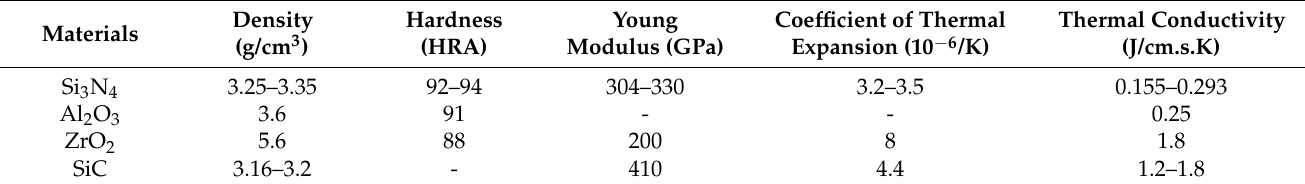
Figure 1. Real/possible applications of ceramics: ( a ) ceramic implant system in medical application [25], ( b ) ceramic turbine rotor [26], ( c ) ceramic crown [27], ( d ) unicondylar knee prostheses [28], ( e ) ceramic femoral head [29], ( f ) ceramic liner [30], ( g ) ceramic textile roller, ( h ) SEM image of SiC abrasive particles [31], ( i ) catalyst honeycombs used in automobile applications [32], ( j ) cross-section of a honeycomb [33], ( k ) Si 3 N 4 -based cutting tools [34], ( l ) Si 3 N 4 ball bearings [35]. Reused with per- mission from Elsevier. Table 1. Prescribed mechanical and physical properties of ceramics [36–38]. Reused with permission from Elsevier.